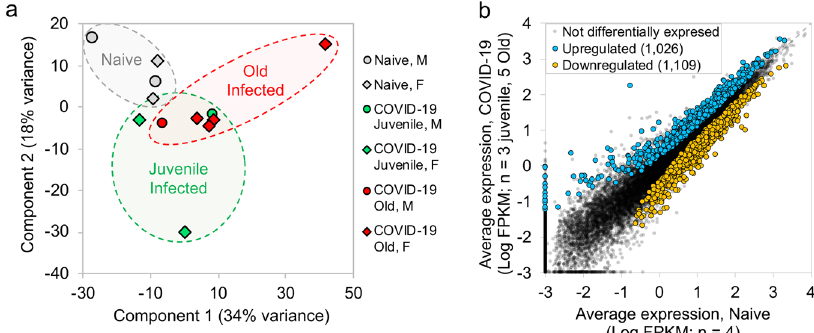
Fig. 1 Gene expression pro fi les for lung tissue samples from macaques infected with SARS-CoV-2 are distinct from naive uninfected samples. a PCA plot showing the clustering of samples based on overall transcriptomic pro fi les. b Differential gene expression plot showing the relative normalized gene expression levels (FPKM) for each gene, with genes signi fi cantly differentially regulated by COVID-19 are